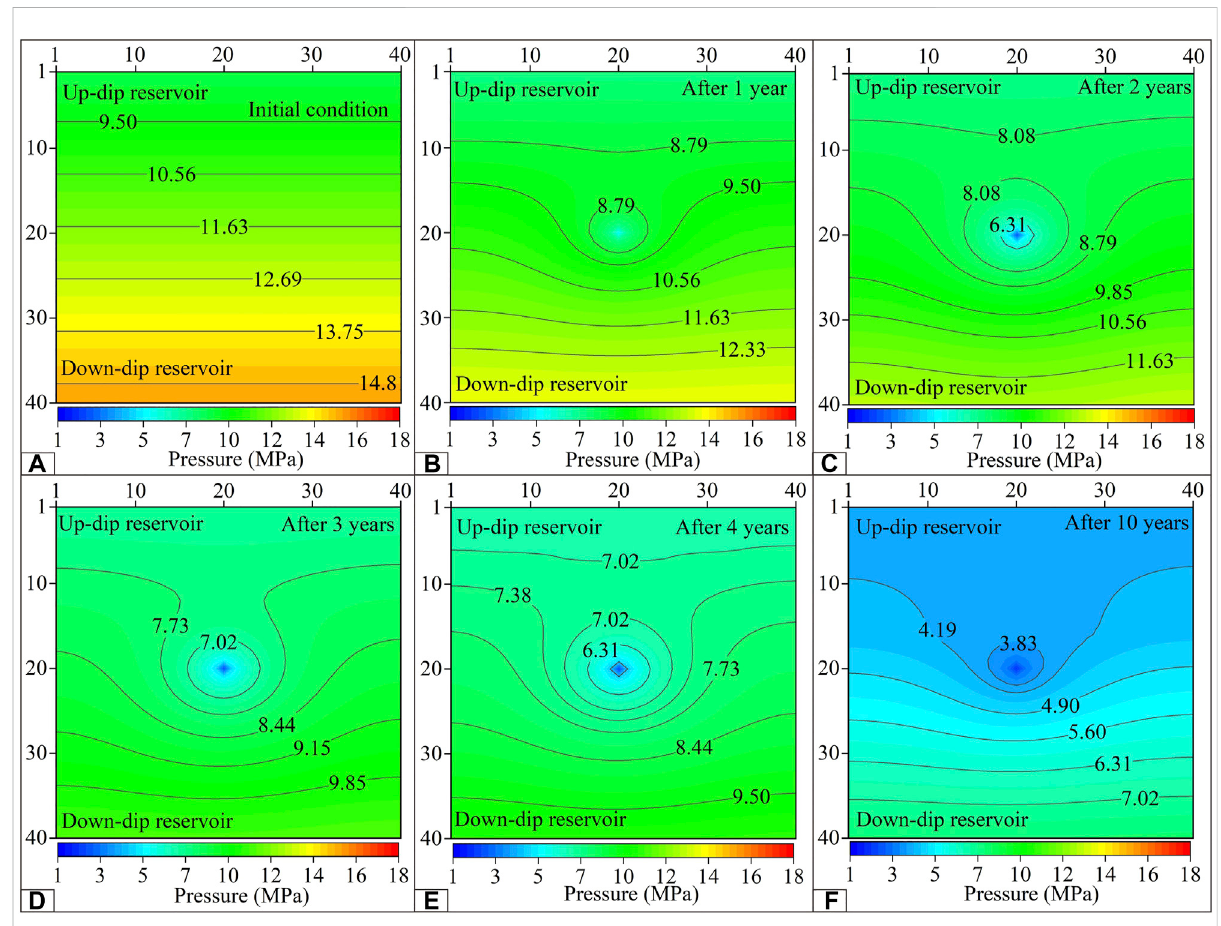
FIGURE 12 (A) Initial reservoir pressure distribution of ISIM. (B) Reservoir pressure distribution after 1 year of drainage in ISIM. (C) Reservoir pressure distribution after 2 years of drainage in ISIM. (D) Reservoir pressure distribution after 3 years of drainage in ISIM. (E) Reservoir pressure distribution after 4 years of drainage in ISIM. (F) Reservoir pressure distribution after 10 years of drainage in ISIM.